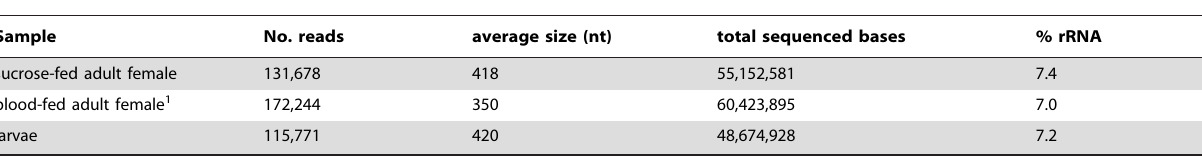
Table 1. Anopheles aquasalis sequencing